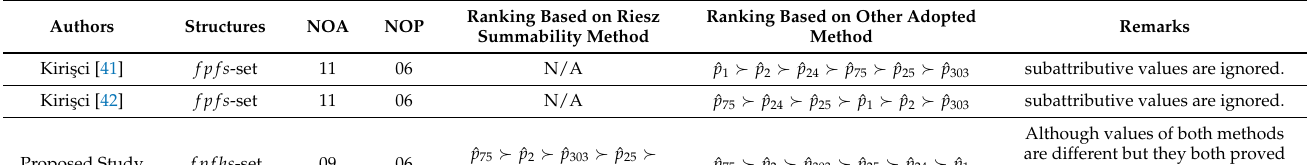
Table 11. Structural analysis of presented structure with predeveloped approaches.